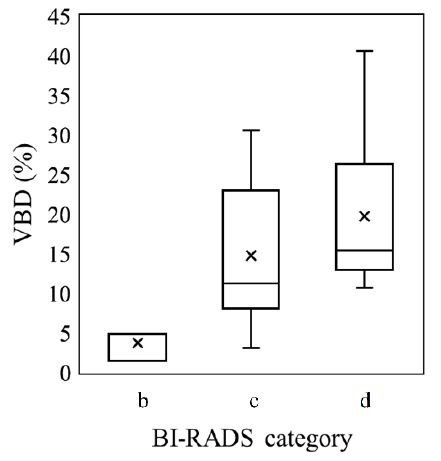
Figure 4. Box plot of VBD for b, c, and d BI-RADS categories. The horizontal line in the box repre- sents the median, and the box contains the 25–75 percentiles. No cases of BI-RADS category a were recorded in this study.